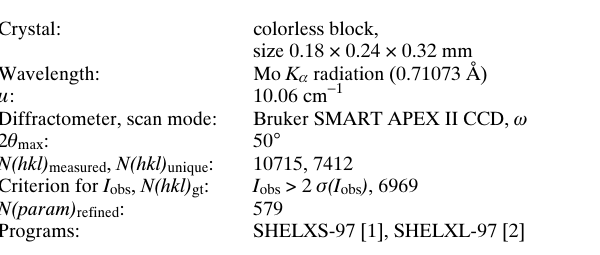
Table 1. Data collection and